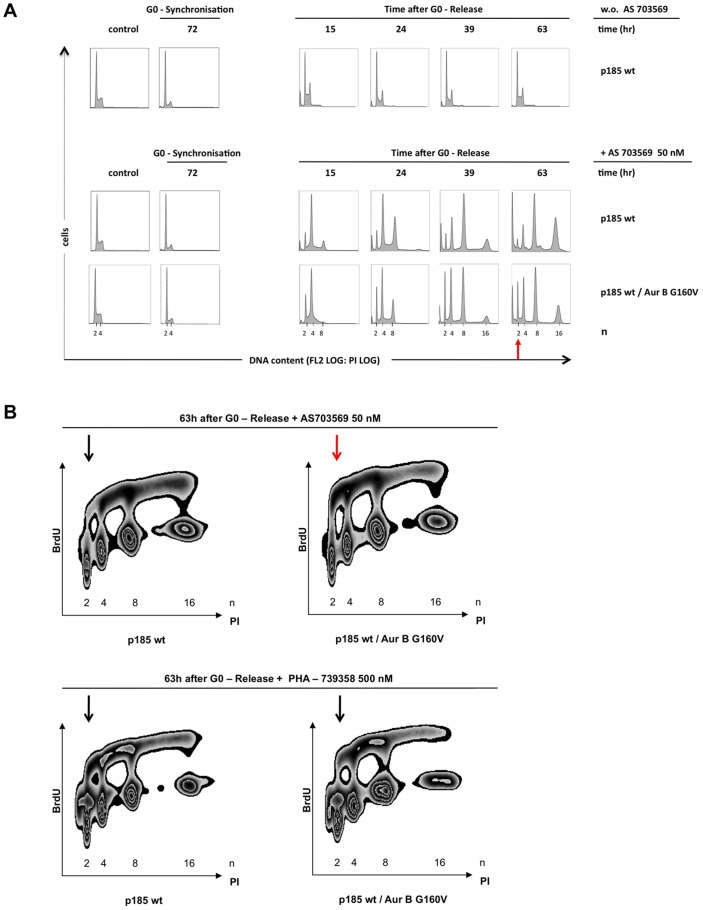
Aurora B G160V mutant constrains endoreduplication and rescues partly a normal cell cycle.Asynchronously growing Ba/F3 p185 wt cells and Aurora B G160V expressing Ba/F3 p185 wt cells (AS) were serum starved for 72 h (SS), then reactivated with 20% serum and simultaneously treated with 500 nM PHA-739358 or 50 nM R763/AS703569 for 63 h. (A) Time course for DNA synthesis after G0-release and exposure to 50 nM R763/AS703569. (B) DNA synthesis was monitored by BRDU pulse for 1 h after 63 h of culture. Only in the presence of 50 nM R763/AS703569 (upper panel) and not of 500 nM PHA-739358 (lower pannel) Aurora B G160V mutant restores the 2n population (arrow), demonstrating regeneration of Aurora B kinase activity.